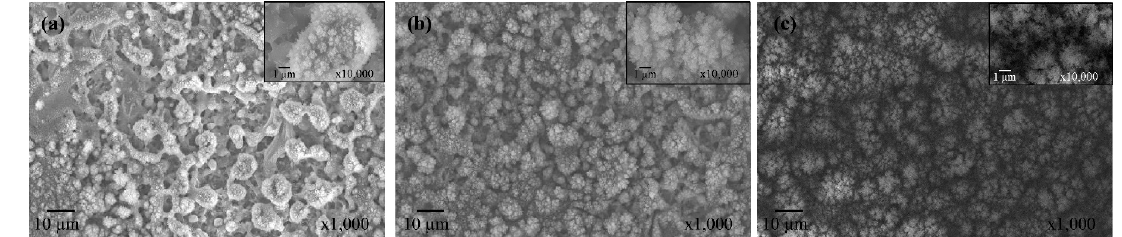
Figure 8. Scanning electron microscopy (SEM) images of ( a ) PT3, ( b ) PT5, and ( c ) PT5P75.